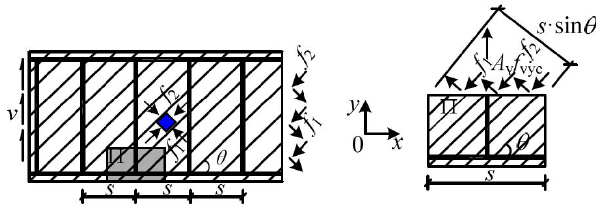
Fig. 3 Schematic diagram of beam principal stress and force